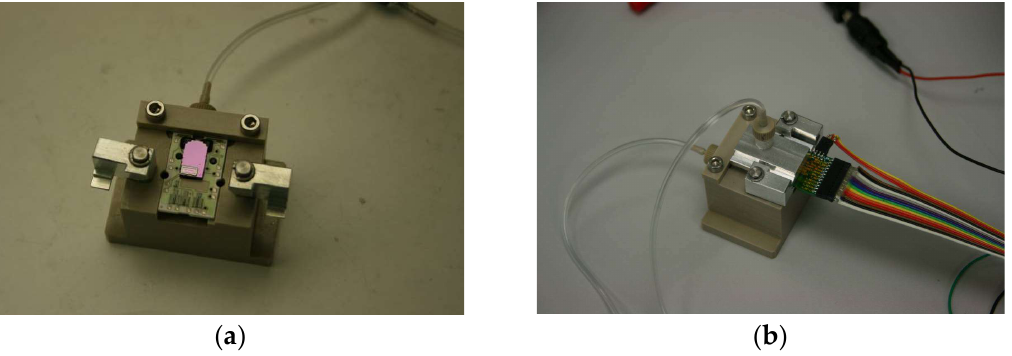
Figure 8. ( a ) Sample holder with the ceramic substrate and the micropump; the piezo actuator, located beneath the substrate, is not visible here. ( b ) Sample holder after positioning of the PCB for electrical connections. The side and top pneumatic connections are used to calibrate the pressure sensors and to control the outlet valve vent port.